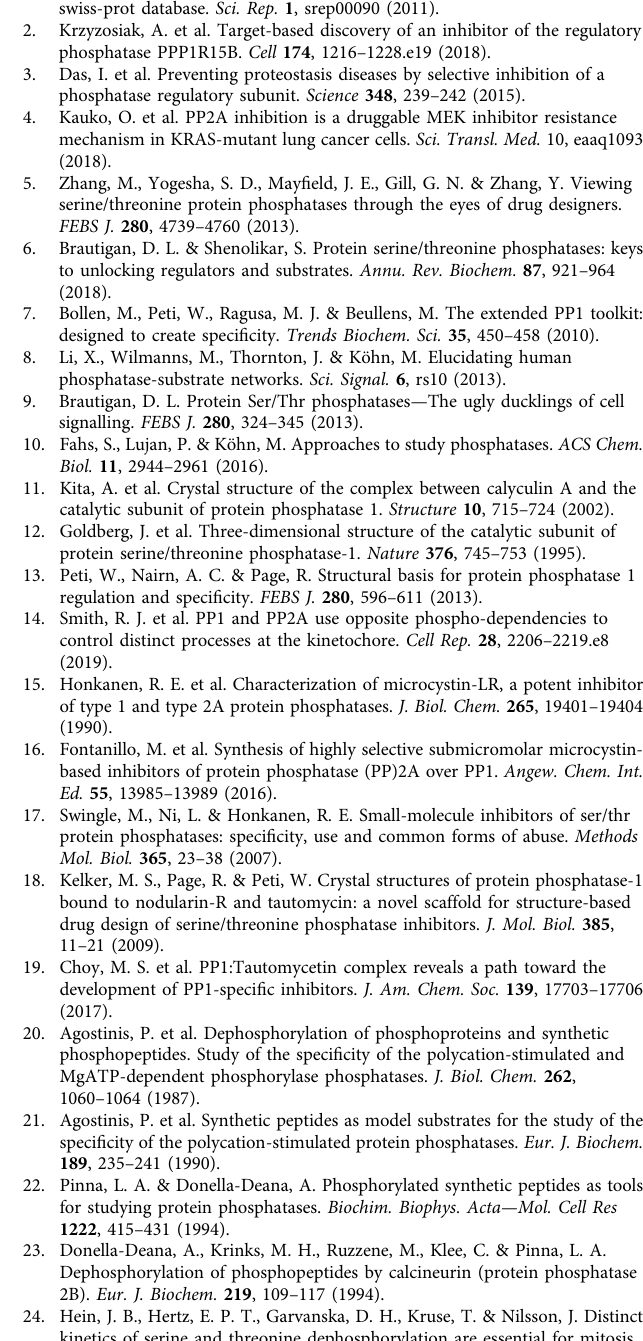
synthesis protocol 36 : First, Fmoc-amino acids (5 eq) were linked by double cou- plings using diisopropylethylamine (DIEA, 6 eq), HBTU, HOBt (both5 eq), DMF